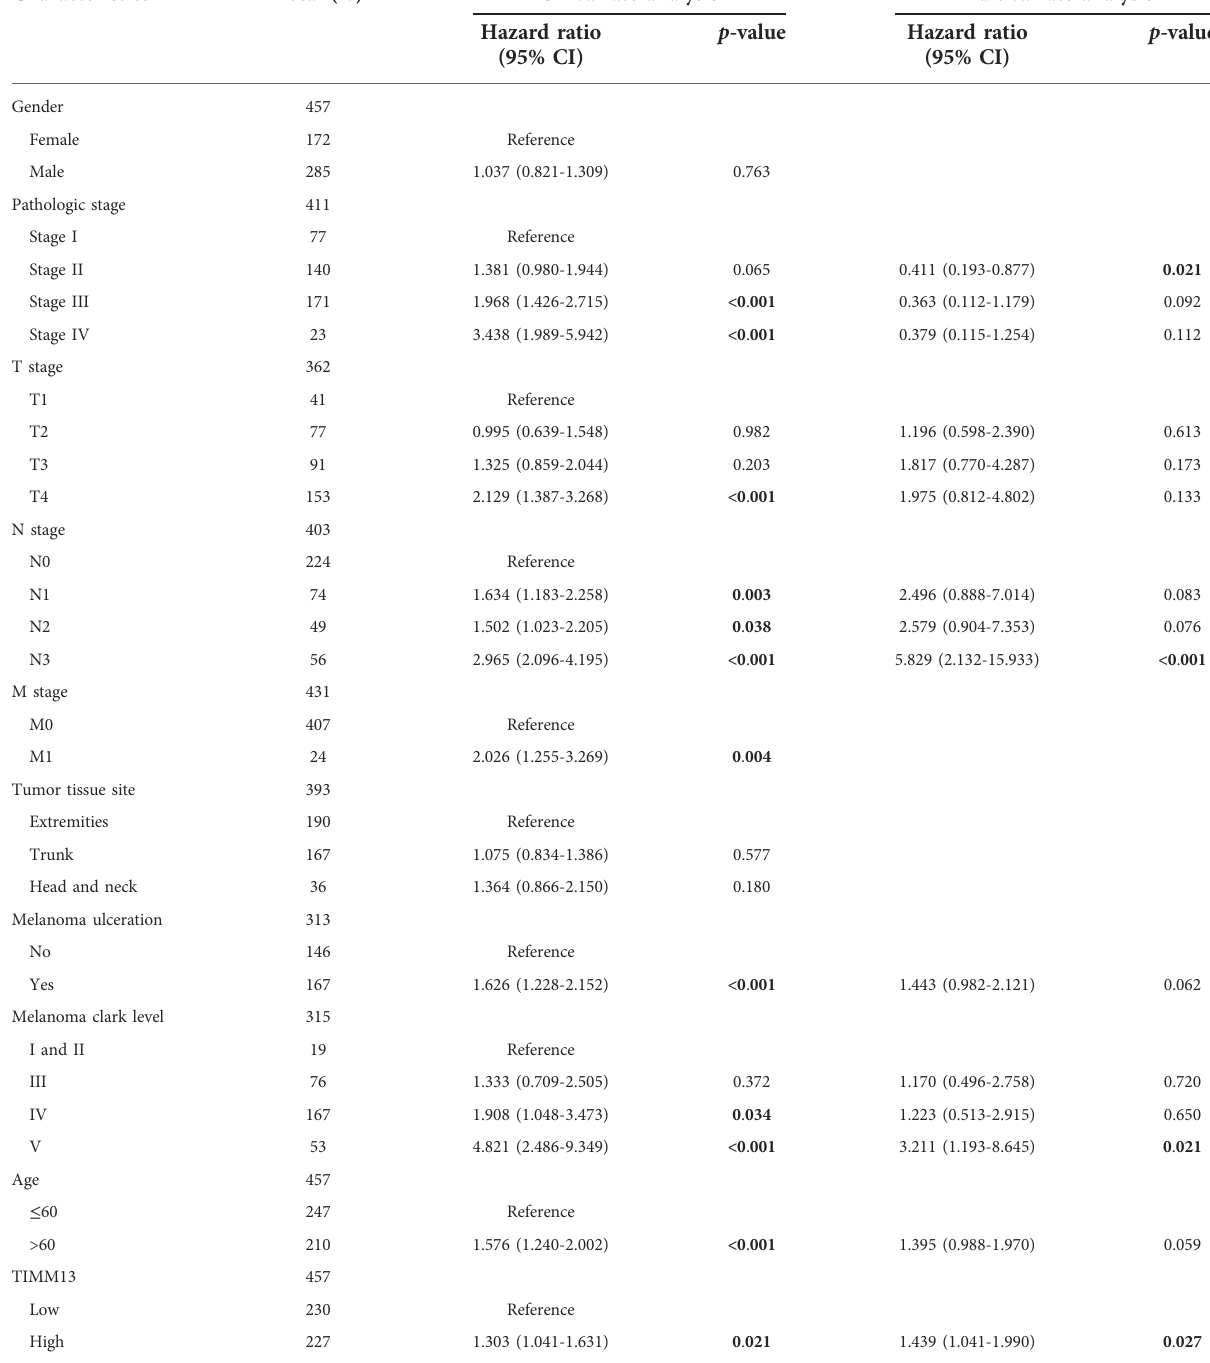
TABLE 3 Univariate and multivariate Cox regression analysis of